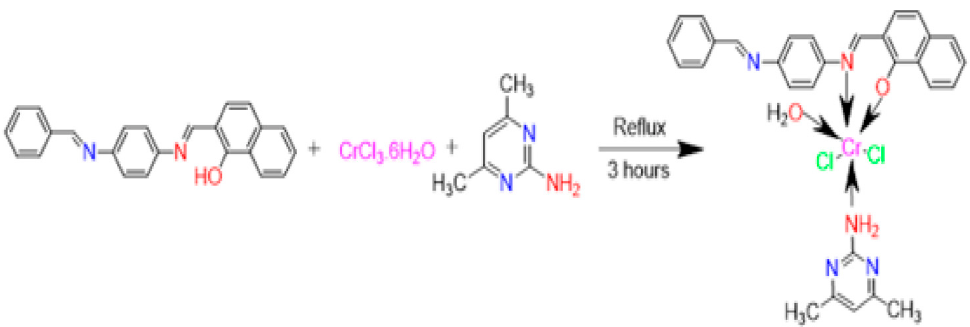
Figure 2. Preparation of the Cr(III) complex ( 4